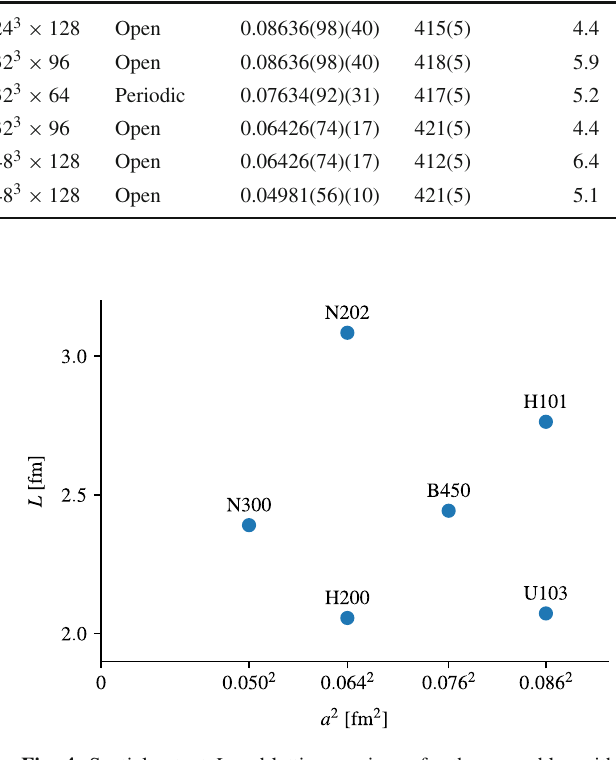
Fig. 4 Spatial extent L and lattice spacing a for the ensembles with SU ( 3 ) f -symmetry used in this